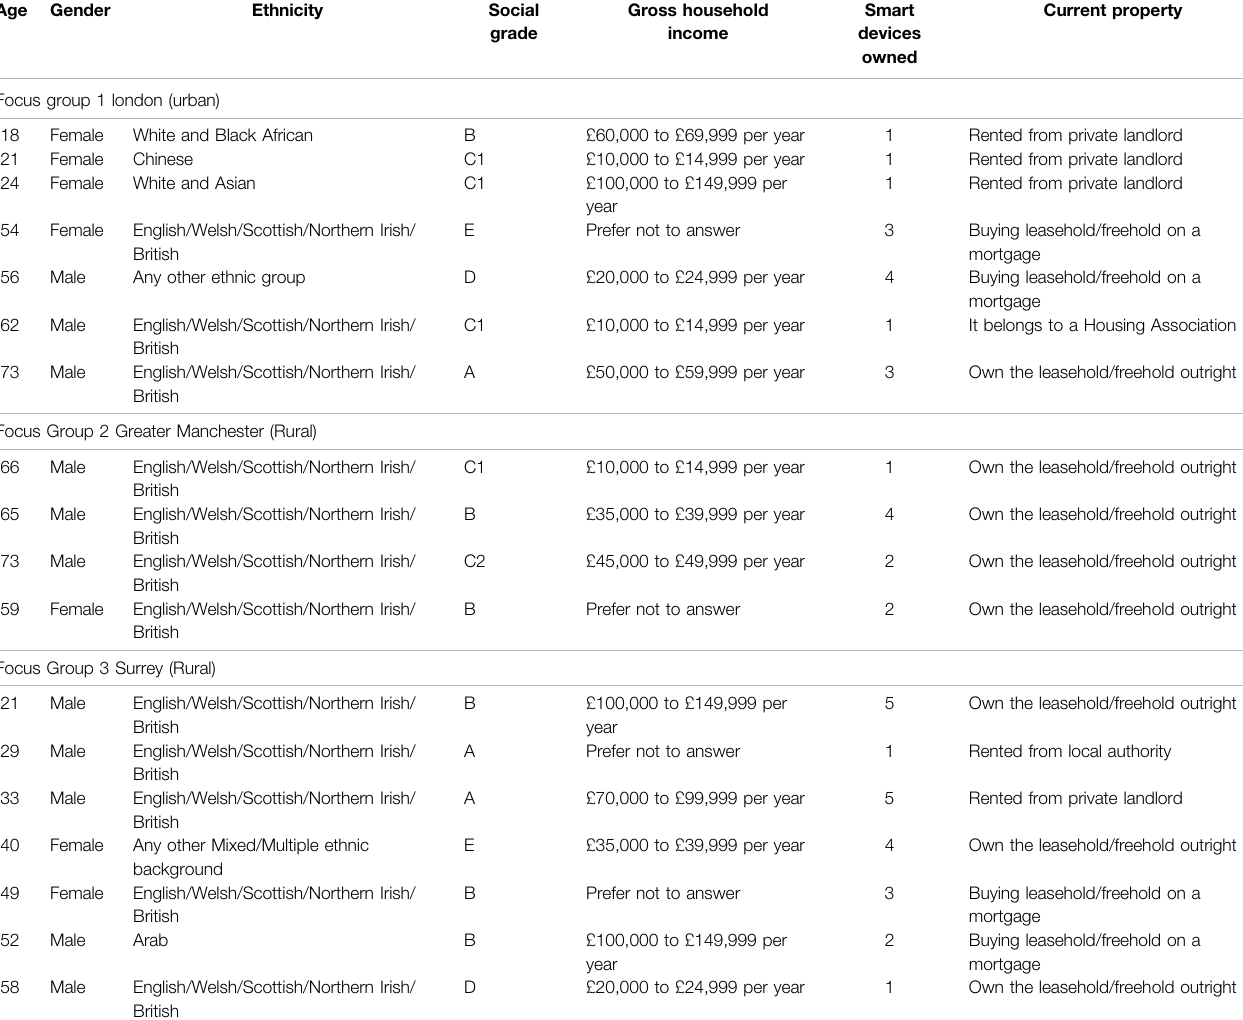
TABLE 2 | Demographic Attributes of Focus Groups in London, Manchester, and Surrey( n (cid:1) 18). Source, authors. Age Gender